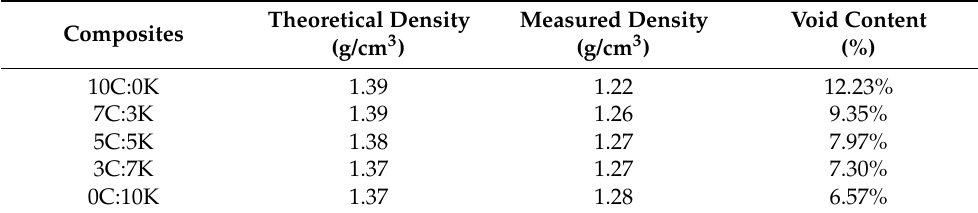
Table 4. Density and void content of hybrid CR/K reinforced phenolic